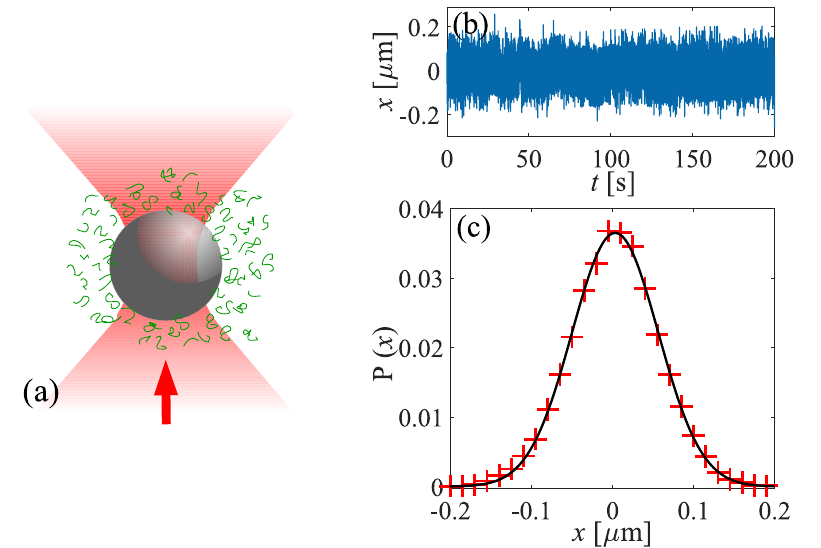
Figure 3. ( a ) Schematic diagram of a trapped spherical probe using optical tweezers in a viscoelastic medium. Arrow shows the direction of the trapping laser beam. ( b ) Representative experimental trajectory of T s 0.002 s of a confined particle (radius 1.95 μm) in an optical trap of trap stiffness k and (cid:31) t = in 0.02 %w / w PAAM to water mixture and, ( c ) the corresponding probability